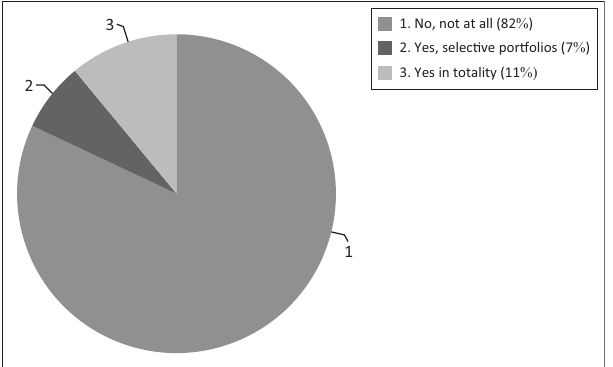
FIGURE 9: The views of the participants about the usefulness of the internal capital adequacy assessment process as a risk management tool.